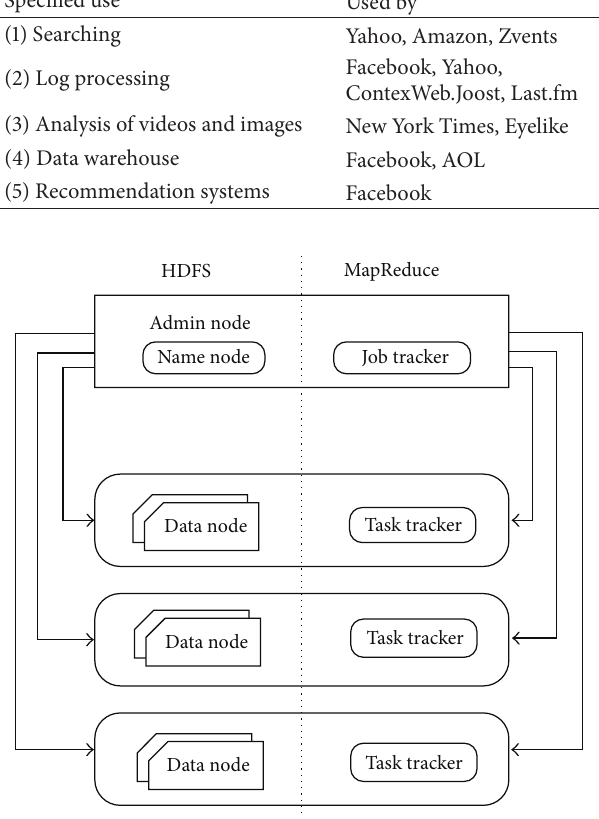
Figure 4: System architectures of MapReduce and HDFS.